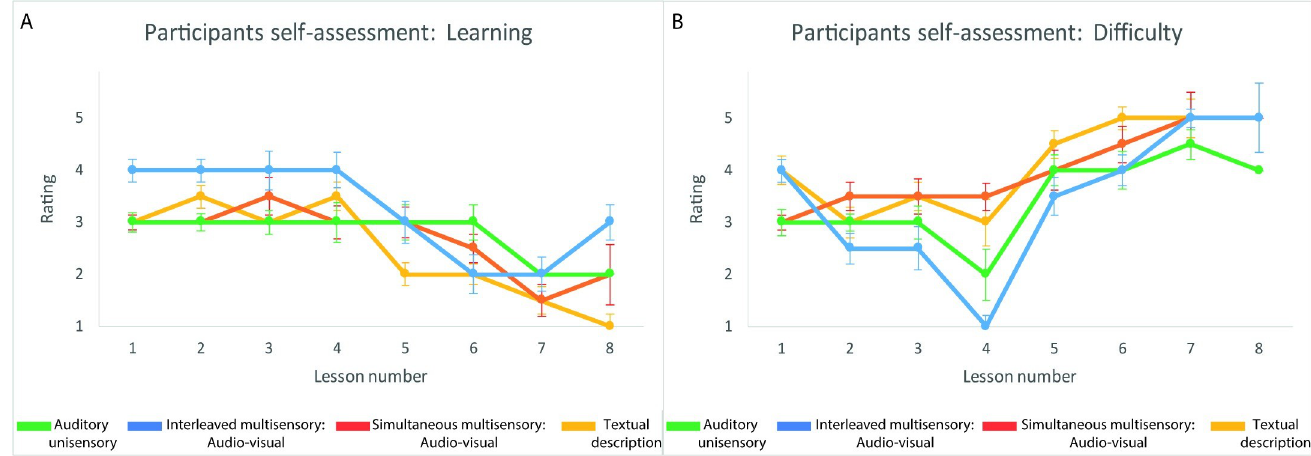
Fig 6. Participants self-assessment. Following each training lesson, and before the end-lesson quiz, participants rated in a 1–5 scale two self-assessment questions: 1) their subjectively perceived learning of the material presented in each lesson, 2) how difficult they subjectively rated each lesson. A. Learning self-assessment: The median of self-evaluation of learning, was highest for participants from the interleaved audio-visual (multisensory) group (blue), followed by participants from the auditory only (unisensory) group (green). B. Difficulty self-assessment: The median of self-evaluation of difficulty, was lowest for participants from the interleaved audio-visual (multisensory) group (blue), followed by participants from the auditory only (unisensory) group (green). Note that all error bars here represent MAD.